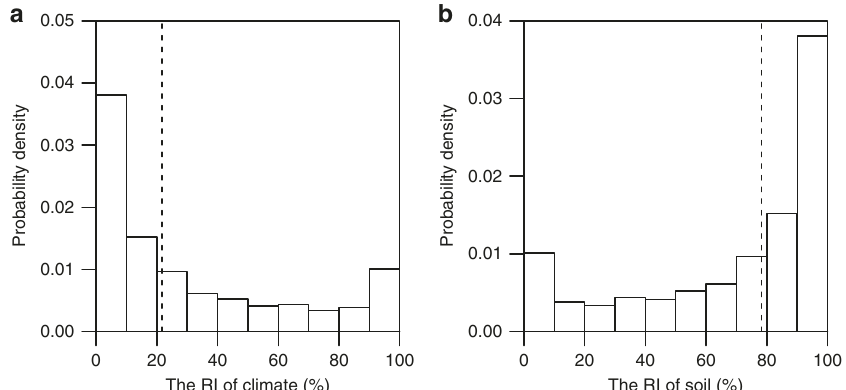
Fig. 4 Relative importance of climate and soil at the local scale. a , b The relative importance of climate (including mean annual temperature and precipitation) and soil (including eight soil physiochemical properties) in controlling subsoil (0.3 – 1 m) organic carbon turnover times, respectively. The dashed line shows the weighted average relative importance of climate and soil across the globe (i.e., 22% for climate and 78% for soil), with weights as the model performance in each 100 × 100 km window